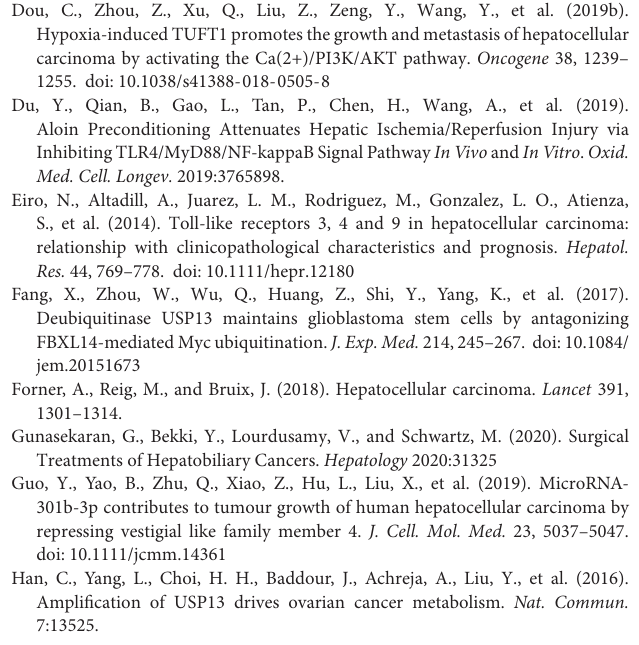
Supplementary Figure 1 | The expression and prognostic significance of USP13 in TCGA data. (A) TCGA data analysis via the GEPIA web tool indicated that USP13 mRNA expression in HCC was significantly higher than that in normal liver tissues. (B) HCC patients with high USP13 level predicted a lower disease-free survival and overall survival. Supplementary Figure 2 | USP13 overexpression promotes the proliferation, EMT, migration, and invasion of HepG2 cells. (A) HepG2 cells were transfected with pcDNA3.1-USP13 and empty vector (EV), respectively, and detected by WB for USP13 expression. (B) CCK-8 assay indicated that USP13 overexpression significantly increased the viability of HepG2 cells. (C) Ectopic expression of USP13 enhanced the proliferation of HepG2 cells as suggested by EdU assay. (D) Overexpression of USP13 markedly promoted the migration and invasion of HepG2 cells. (E) USP13 overexpression reduced E-cadherin expression but increased the levels of N-cadherin and vimentin in HepG2 cells. ∗ P < 0.05. Supplementary Figure S3 | USP13 overexpression promotes the proliferation, EMT, migration, and invasion of LO2 cells. (A) LO2 cells were transfected with pcDNA3.1-USP13 and empty vector (EV), respectively, and detected by WB for USP13 expression. (B) CCK-8 assay indicated that USP13 overexpression significantly increased the viability of LO2 cells. (C) Ectopic expression of USP13 enhanced the proliferation of LO2 cells, as suggested by EdU assay. (D) Overexpression of USP13 markedly promoted the migration and invasion of LO2 cells. (E) USP13 overexpression reduced E-cadherin expression but increased the levels of N-cadherin and vimentin in LO2 cells. ∗ P < 0.05. Supplementary Figure 4 | The levels of TLR4, MyD88, and P-NF- κ B p65 in HCC tissues and cells. (A) TCGA data analysis via the GEPIA web tool indicated that TLR4 mRNA expression in HCC was significantly lower than in that in normal liver tissues. (B) The levels of TLR4 and MyD88 protein in HCC cell lines (SK-HEP-1, HepG2, Huh7, and Hep3B) and a normal hepatic cell line (LO2). (C) The expressions of TLR4, MyD88, and P-NF- κ B p65 in subcutaneous tumor tissues from the USP13 knockdown group were prominently lower than those in the control group. ∗ P < 0.05. Supplementary Figure 5 | TLR4 restoration reverses USP13 knockdown-induced effects on Huh7 cells. (A) CCK-8, (B) EdU, and (C) transwell assays were performed to assess the proliferation, migration, and invasion of Huh7 cells after transfecting with corresponding vectors. ∗ P <